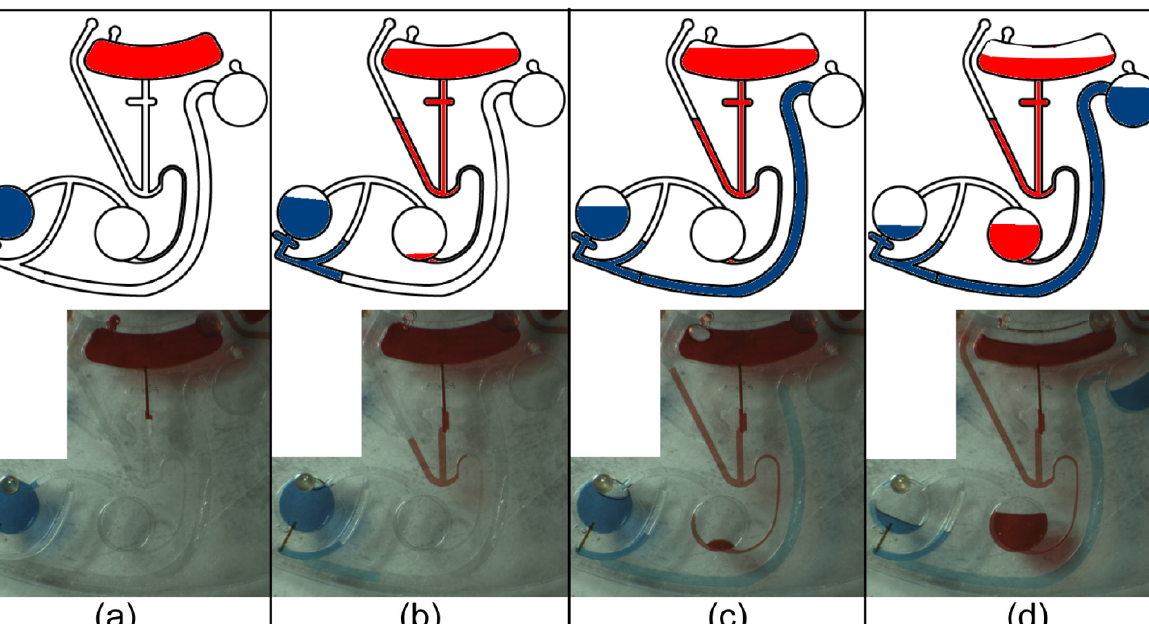
Figure 4. Schematics and strobed images of the gas-liquid pump in operation; t indicates the time elapsed. (a) Sample Chamber is filled with PAS (blue); 0 rpm, t = 0 s; (b) Pumping fluid (red) has begun to empty and displacing the PAS from the Sample Chamber; 300 rpm, t = 12 s; (c) PAS has been displaced up the Transfer Channel towards the Final Chamber, with an air gap between the two liquids; 300 rpm, t = 41 s; (d) PAS has been displaced into the Final Chamber by the pumping liquid; 700 rpm, t = 420